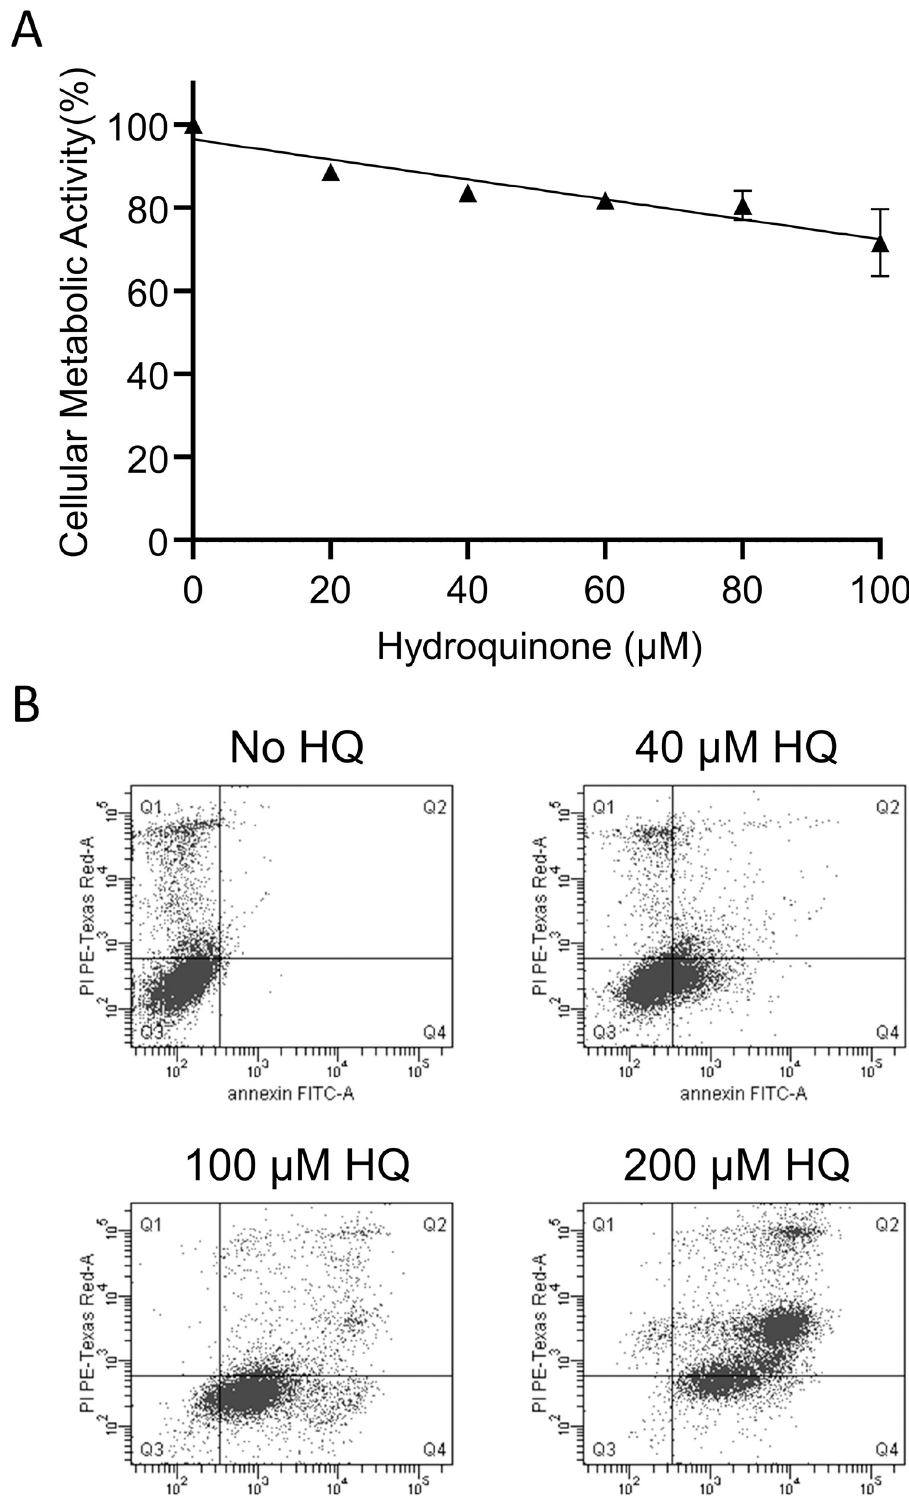
Fig 5. Viability of AR42J cells in the presence of hydroquinone (HQ). Cells were treated with indicated concentrations of HQ for 24 h at 37 ˚C. A) The levels of cellular metabolic activity were analyzed by MTT assay